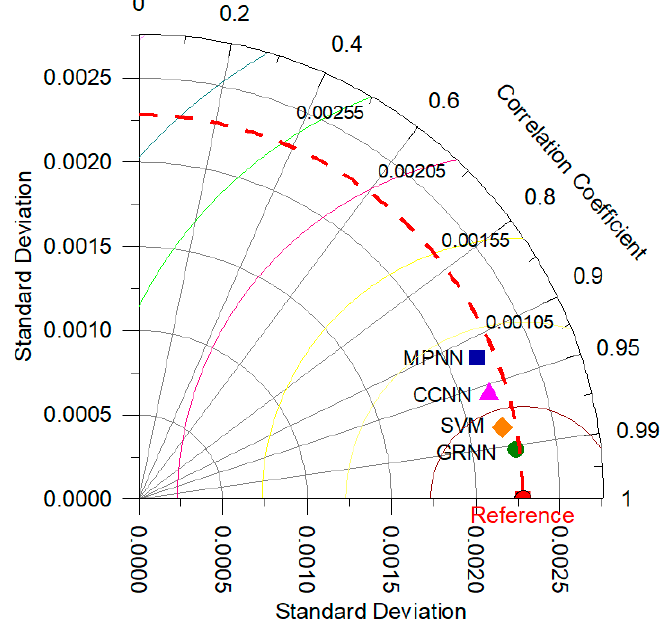
Figure 10. Taylor diagram visualization of ANN and SVM model performance.